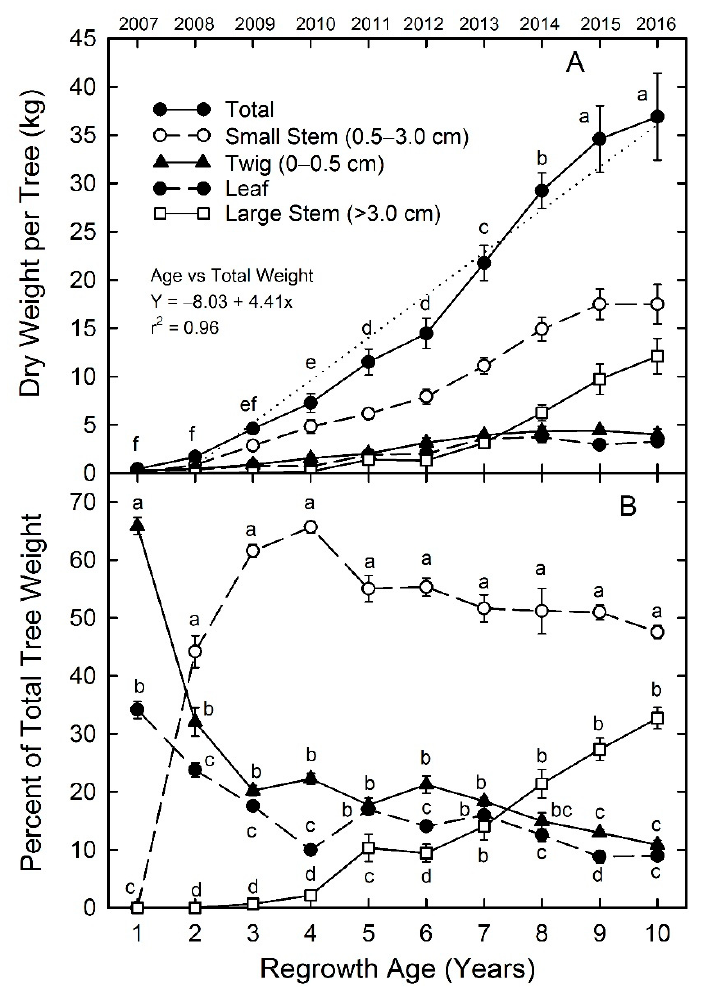
Figure 6. Canopy components in actual dry weight ( A ) and as a percentage of total dry weight ( B ). Vertical bars on each mean indicate ±1 standard error. Means with different letters across all ages (panel A), or within each regrowth age (panel B) are significantly different at p ≤ 0.05. Dotted line in panel A is the linear regression between age and total weight (equation shown).